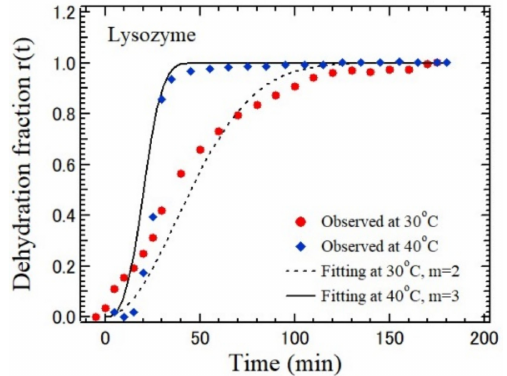
Figure 18. Time dependence of the normalized fraction of a tetragonal HEWL crystals at 30 and 40 ◦ C